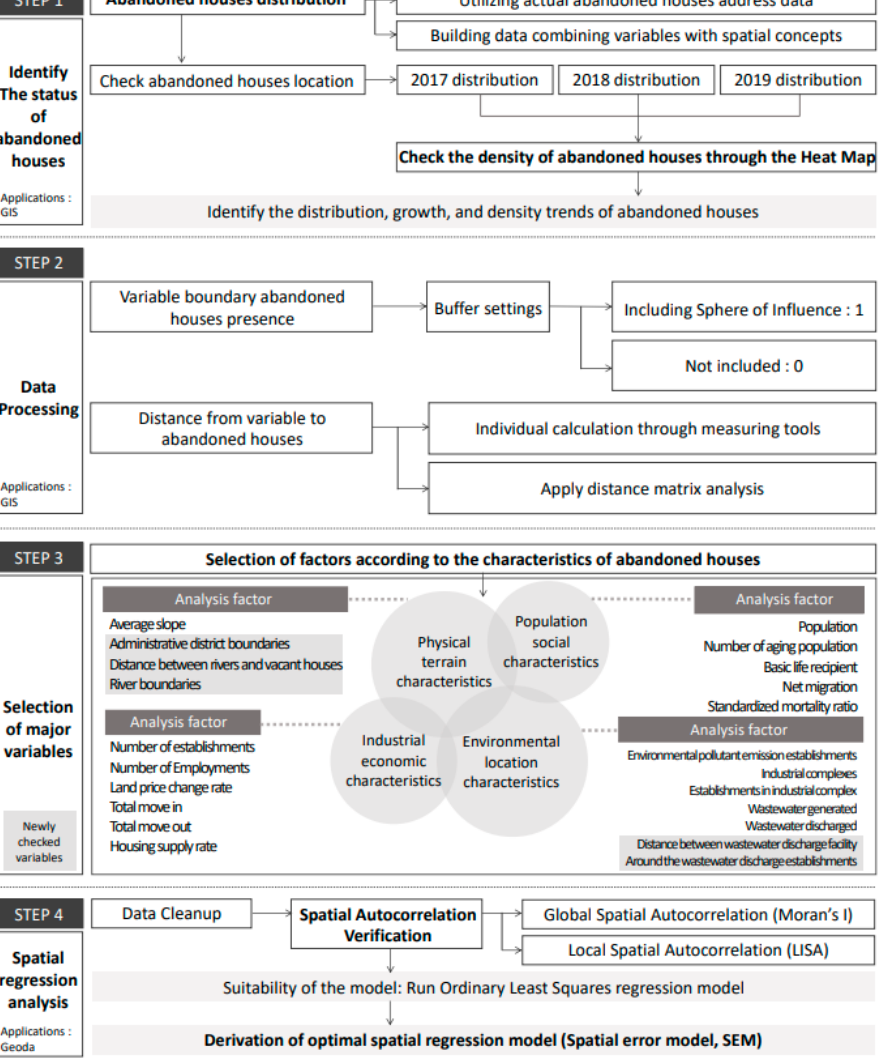
Figure 1. Study method and flowchart .